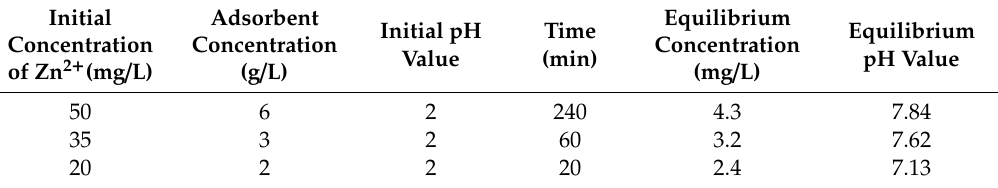
Table 5. The adsorption results of CFAMH for Zn 2 + .